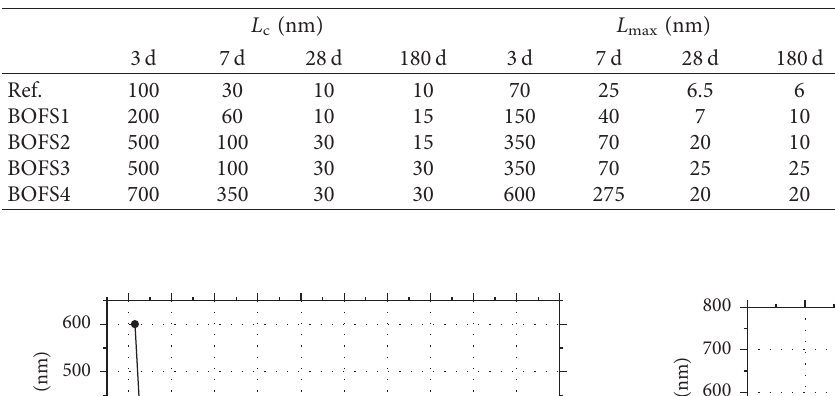
Figure 6: Critical pore radius of cement pastes with BOFS at different curing ages. Table 4: L c , L max , and permeability of BOFS-blended mixtures.